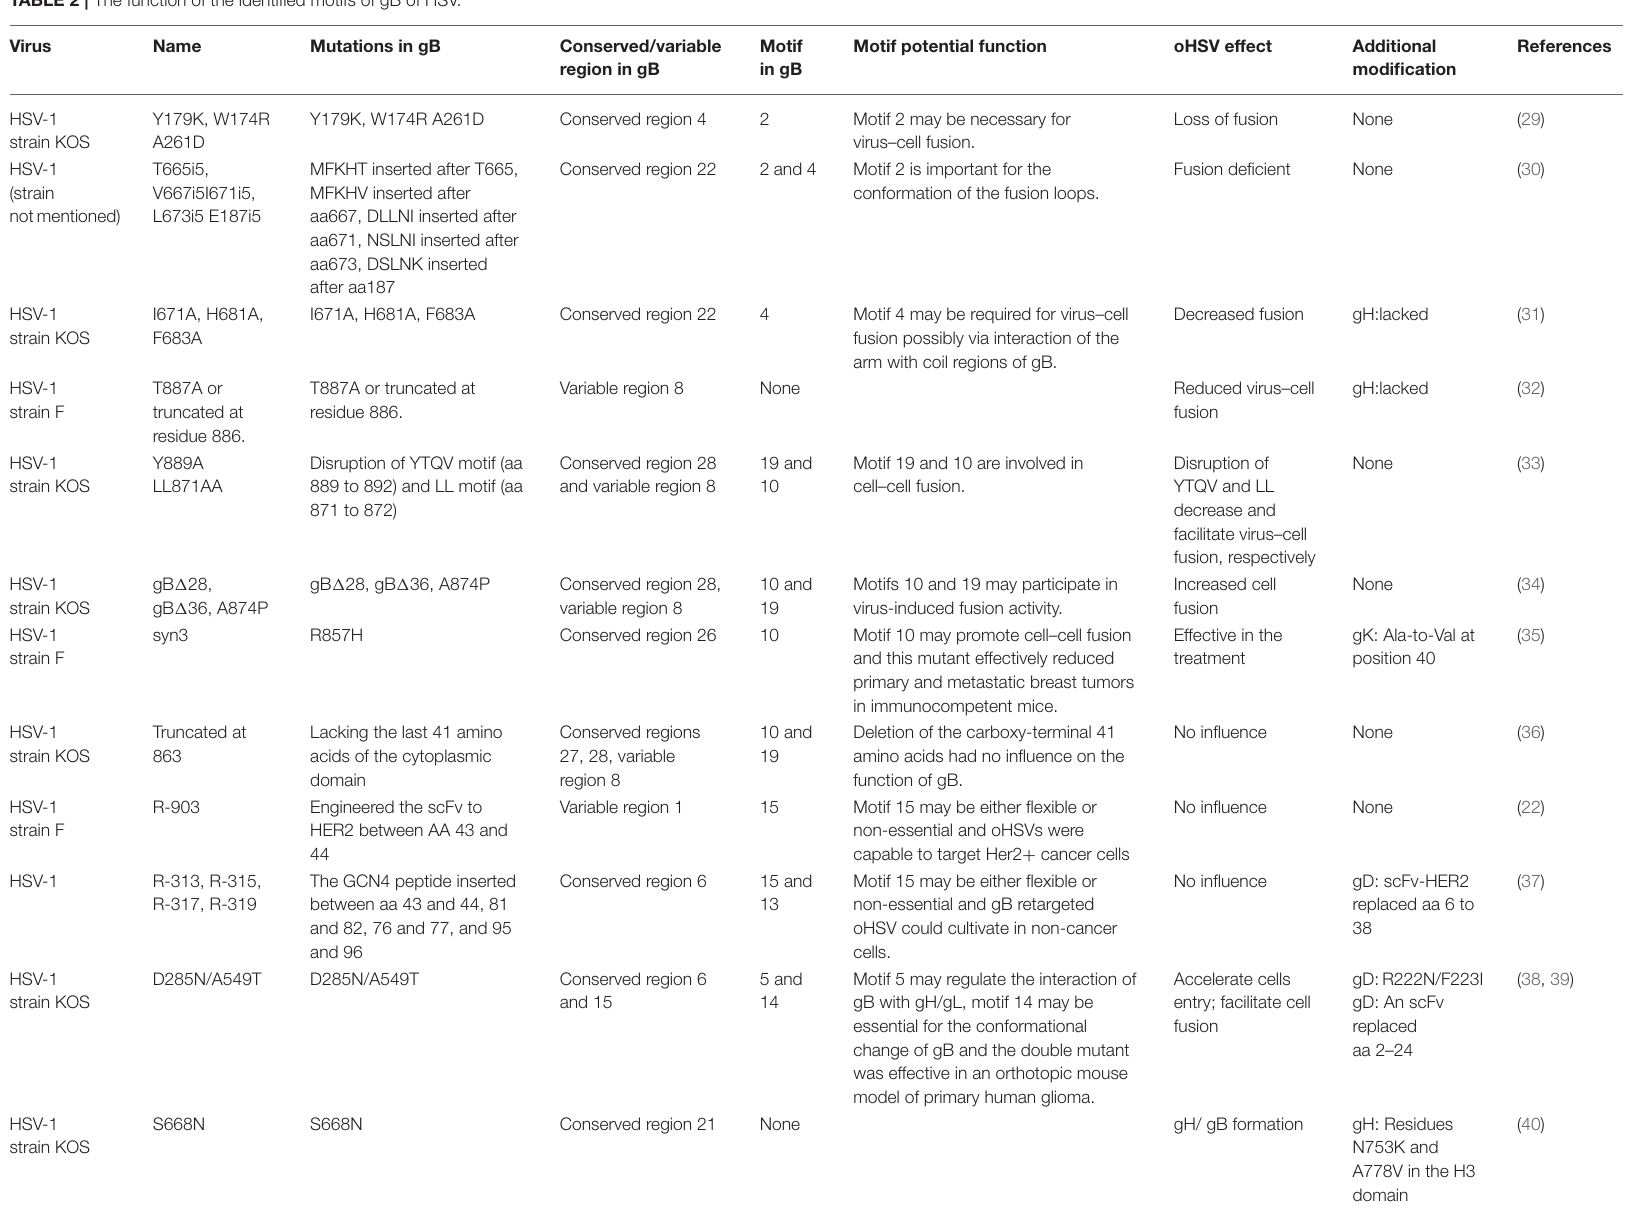
TABLE 2 | The function of the identified motifs of gB of